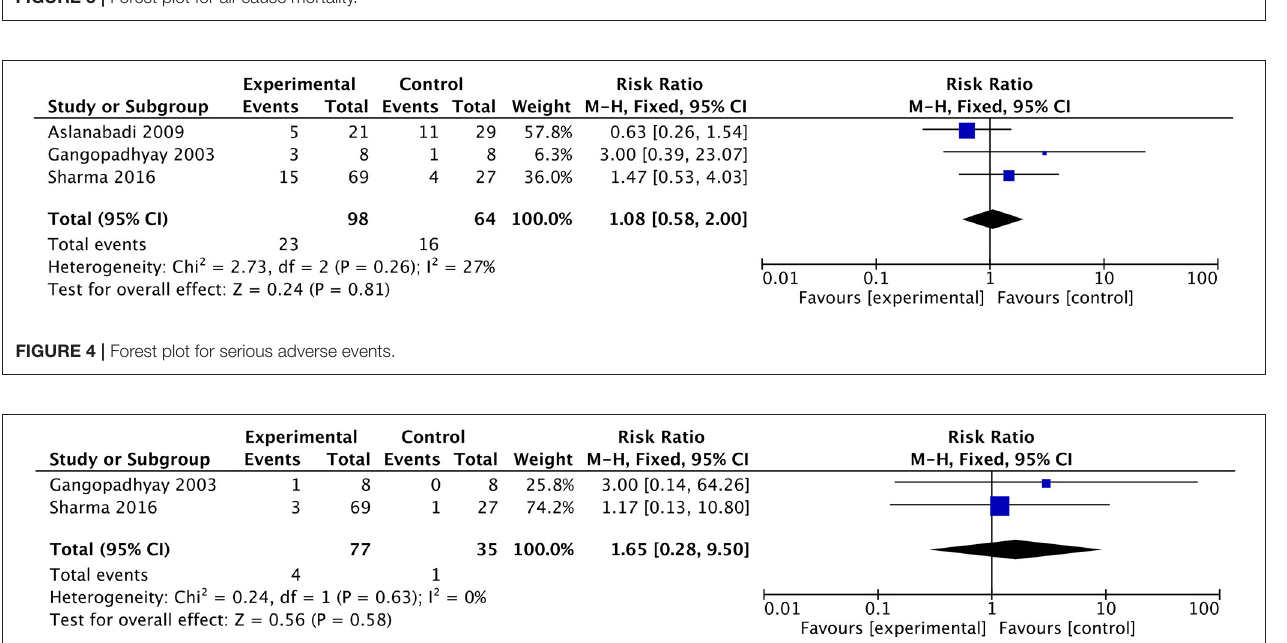
FIGURE 3 | Forest plot for all-cause mortality.